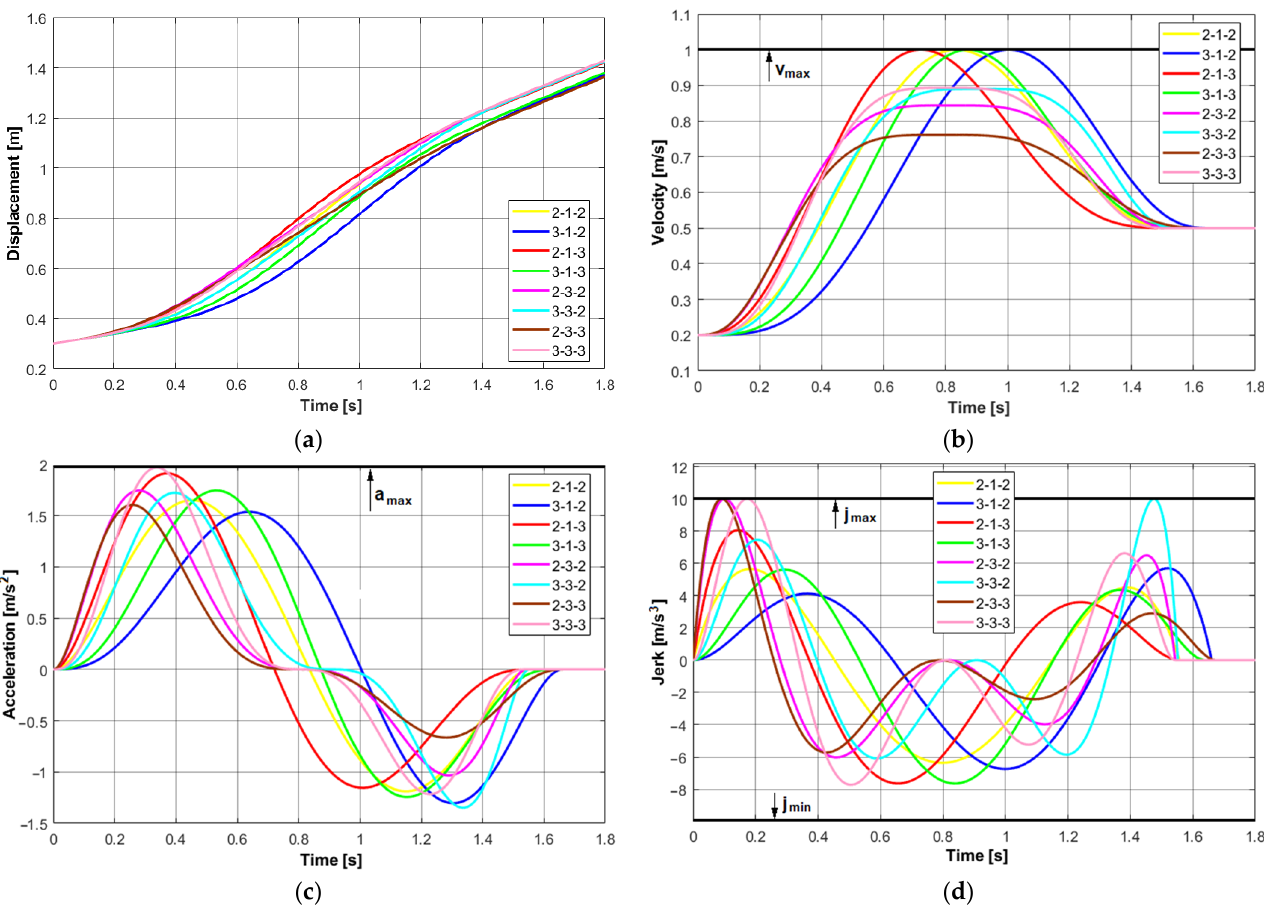
Figure 4. Profiles of kinematic quantities for the trajectories with velocity, acceleration and jerk constraints: ( a ) displacement; ( b ) velocity; ( c ) acceleration; ( d ) jerk.